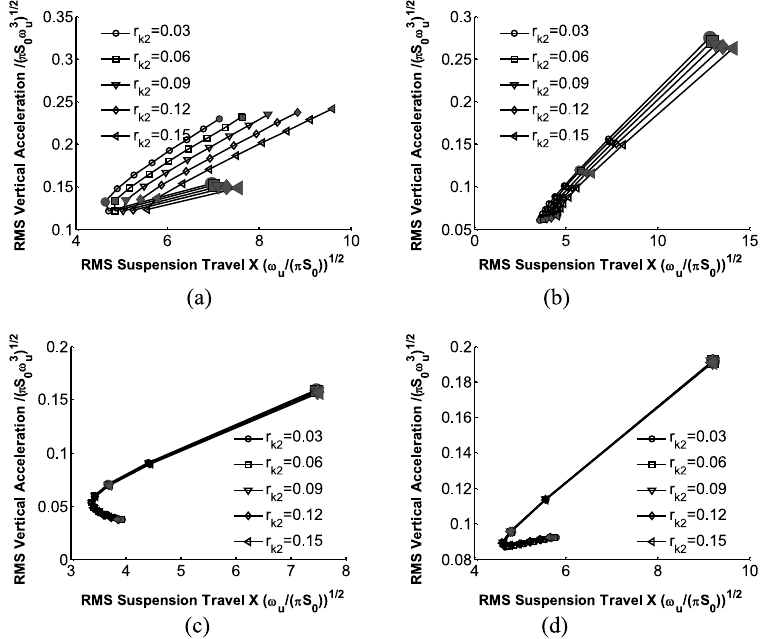
Fig. 10. Relationship between RMS acceleration and RMS suspension travel with layout s8 (effect of centering spring k 2 and damping): (a) Passive; (b) Groundhook; (c) Hybrid; (d) Skyhook.